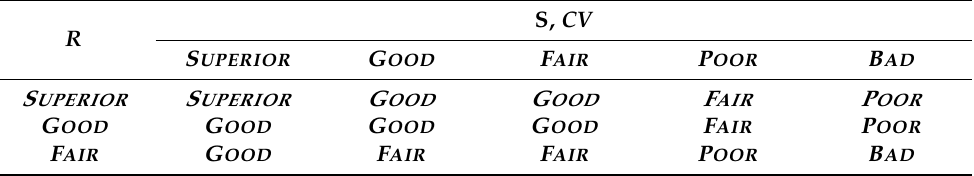
Table 17. A qualitative rating assignment based on the aggregate reliability of CAT portfolio risk estimates based on the reliability of the CAT model computations and the Reliability value R and the S assessment for the individual numerical value for the loss being evaluation. Note that for each loss values considered, a separate Reliability Value applies. Consistent with the recommendations of Section 5.1, R values of Poor and Bad are not